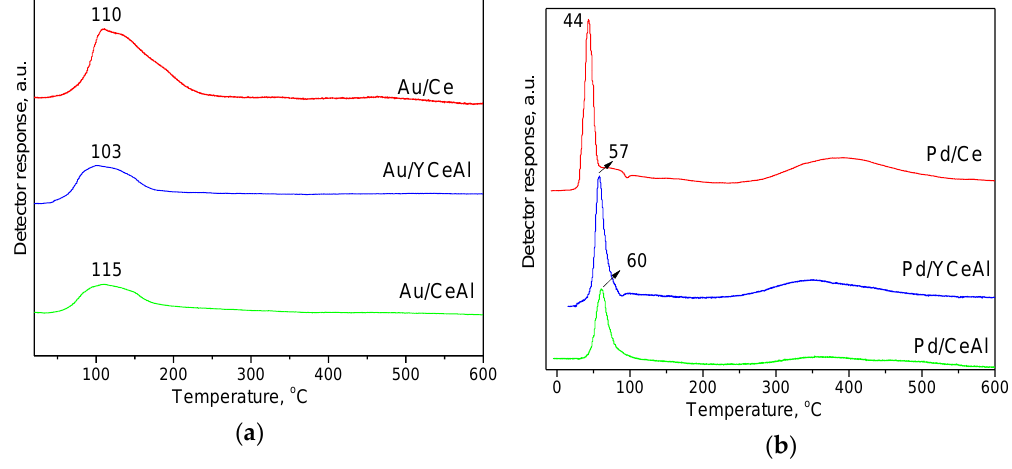
Figure 5. Temperature programmed reduction (TPR) profiles of: ( a ) Au-based samples; ( b ) Pd-based samples.